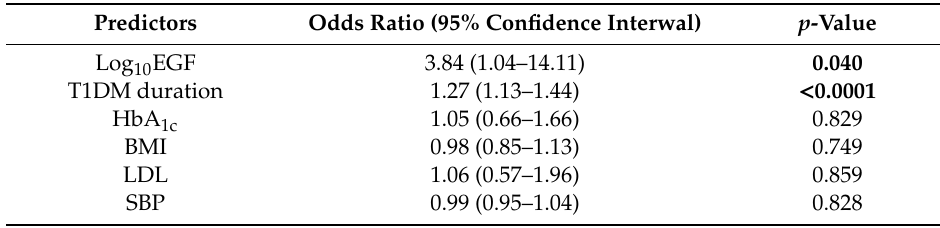
Abbreviations: see Table 2. The bolded p -values are those which are statistically